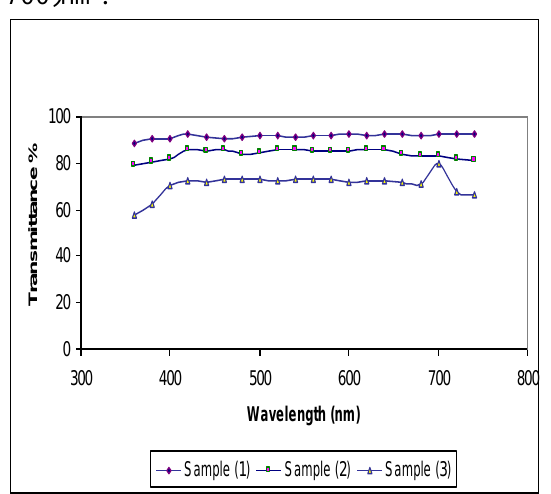
Fig.1: Variation of transmittance with the wavelength of the three different glass samples.